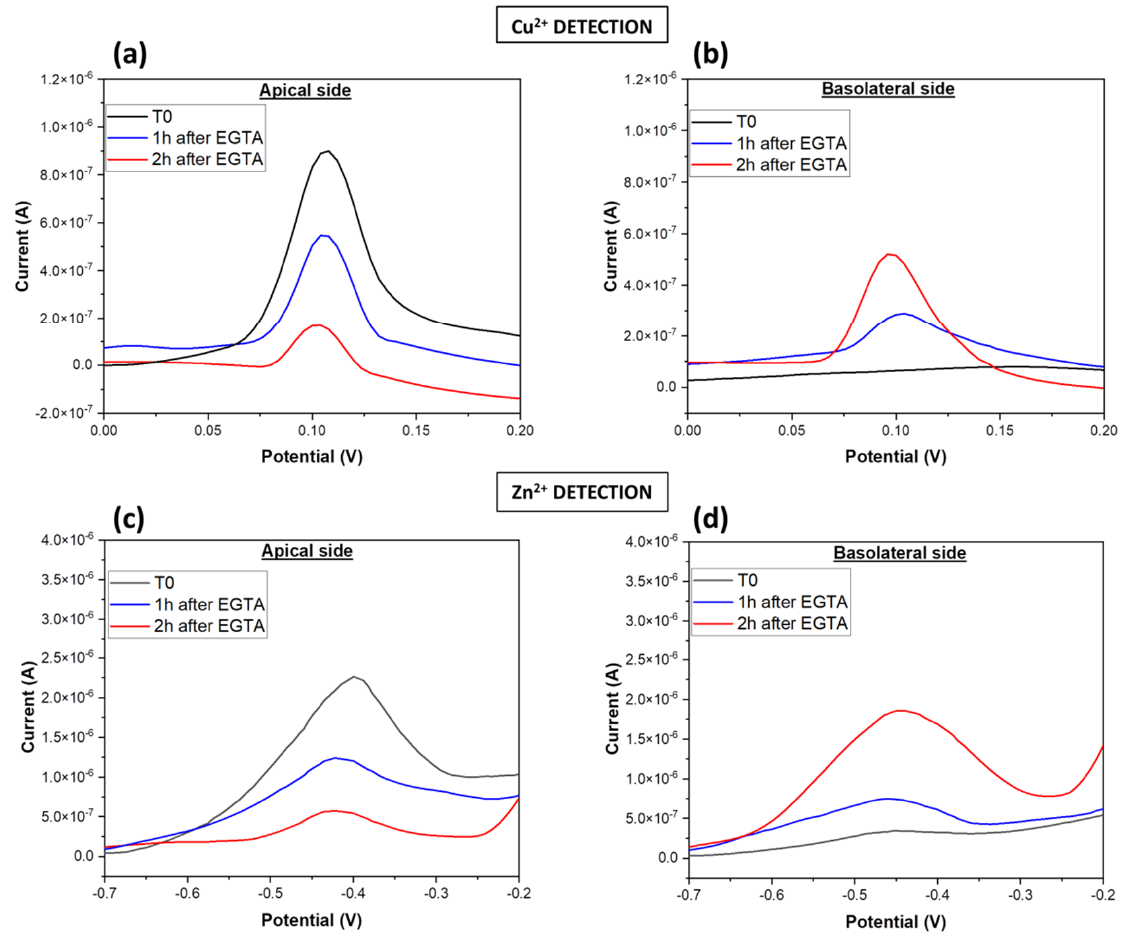
Figure 6. Square-wave anodic stripping voltammograms of Cu 2+ and Zn 2+ in Transwell™ cell culture systems. SWASV for copper detection in apical compartment ( a ) and basolateral side ( b ) of transwell Caco-2 culture system at different time points before (T0) and after 1 h, 2 h of EGTA treatment. SWASV for zinc detection in apical compartment ( c ) and basolateral side ( d ) of transwell Caco-2 culture system at different time points before and after EGTA exposure.